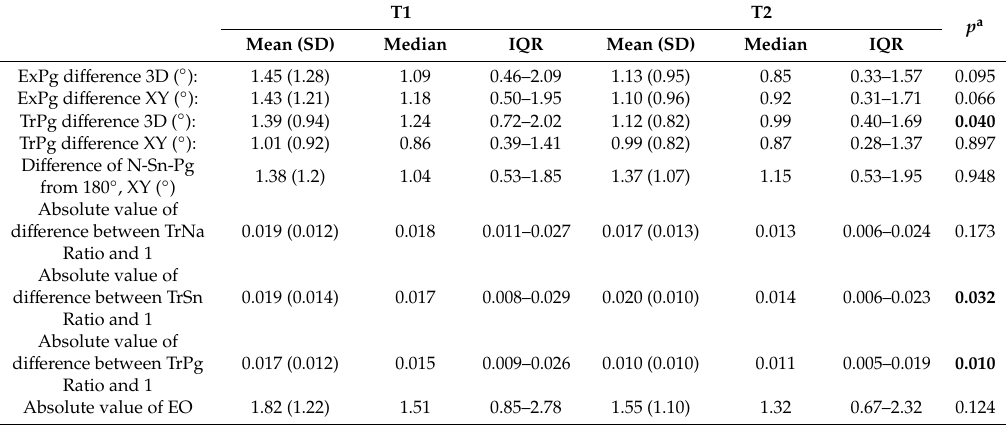
Table 2. The course of facial symmetry measured with surface-based variables at T1 and T2. 3D: three-dimensional; XY, coronal plane; SD = Standard deviation; IQR = Inter quartile range; Bold